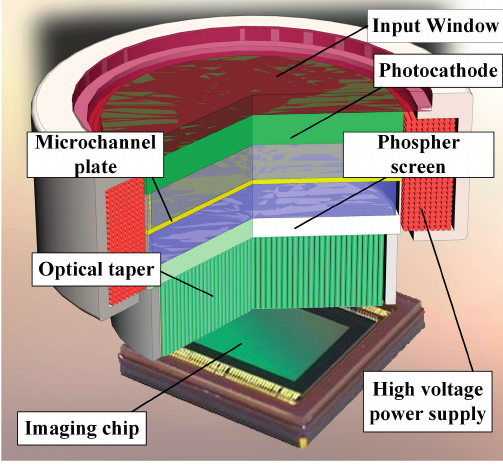
Figure 1. Internal structure of the intensifier